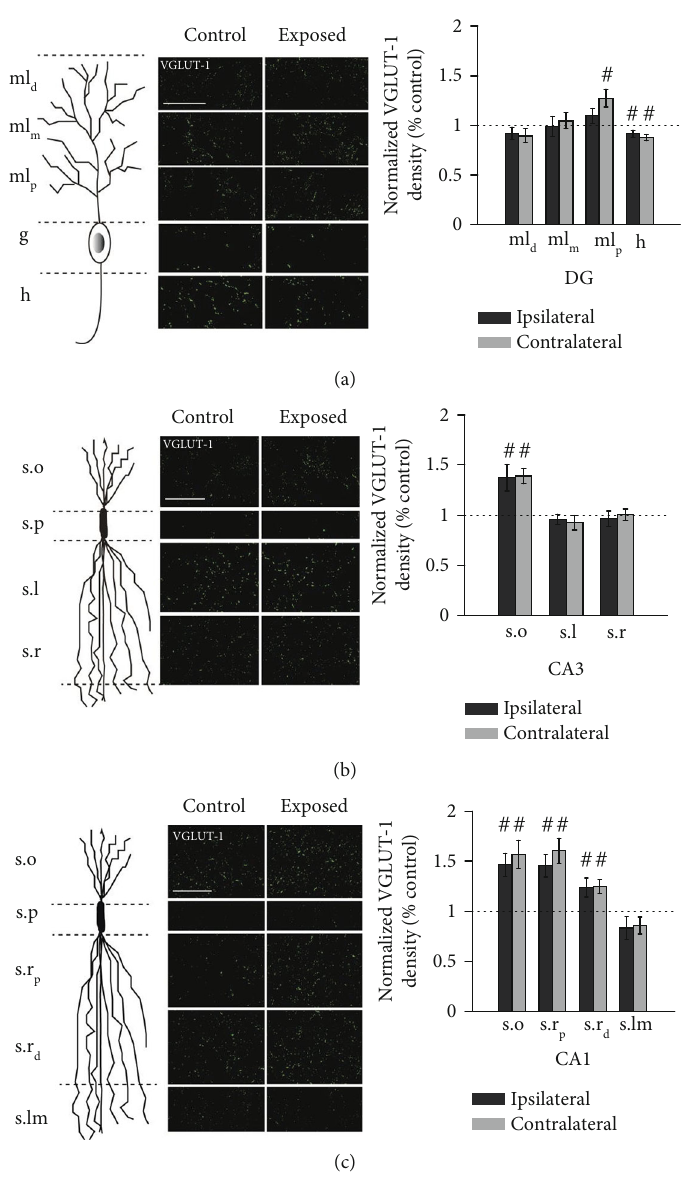
Figure 3: VGLUT-1 puncta density primarily increases in dentate gyrus (DG), area CA3, and area CA1 two weeks after noise exposure. Schematic granule cell in DG (a), pyramidal neuron in CA3 (b), and pyramidal neuron in CA1 (c), depicting organization of inputs corresponding to the layers on the right, which are images of VGLUT-1 labeling in CA1 at 400x magni fi cation. Scale bar, 50 μ m. Mean ( ± SEM) normalized VGLUT-1 puncta density (per 10 4 μ m 2 ; normalized to respective control) in the dentate gyrus (DG) (a), area CA3 (b), and area CA1 (c) two weeks following noise exposure are shown on respective right panels. # When compared to the controls (dashed line), p ≤ 0 : 05 . ml : distal region of molecular layer; ml : middle region of molecular layer; ml : proximal region of molecular layer; h: d m p : proximal region of stratum radiatum; s.r : distal region of hilus; s.o: stratum oriens; s.l: stratum lucidum; s.r: stratum radiatum; s.r p d stratum radiatum; s.lm: stratum